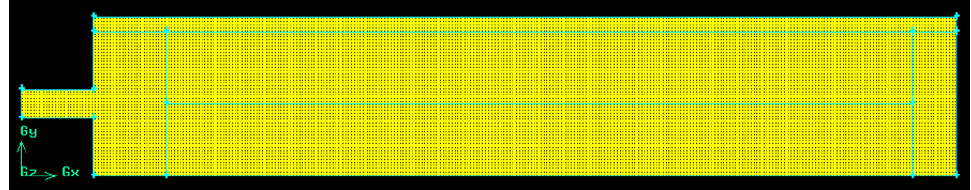
Figure 2. Schematic diagram of micro-combustor mesh.